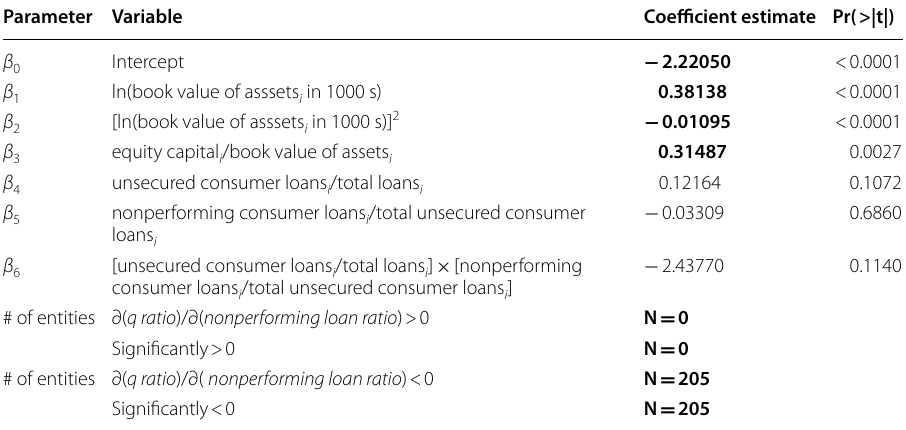
The data set includes 205 top-tier publicly traded bank holding companies at the end of 2016 with plausible values of nonperforming unsecured consumer loans and total loans exceeding 10 percent of assets. Financial performance is gauged by Tobin’s q ratio. Nonperforming loans are the sum of past due and nonaccruing loans and gross charge-offs. Total unsecured consumer loans include gross charge-offs. Statistical significance is computed from robust standard errors. Bold values indicate statistical significance at stricter than 0.10. Adjusted R 2 0.6626. AIC = − =